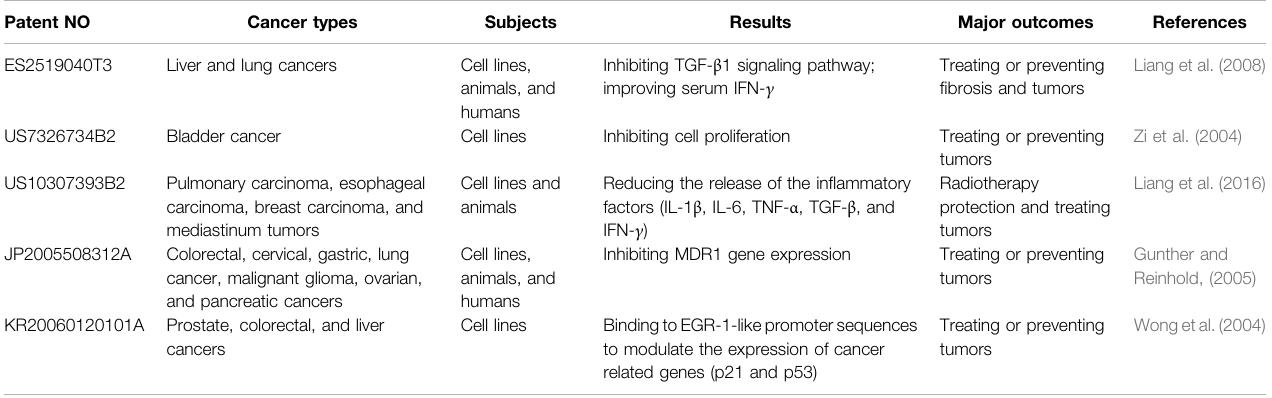
TABLE 6 | Anticancer effects of naringin based on google patents and US patents